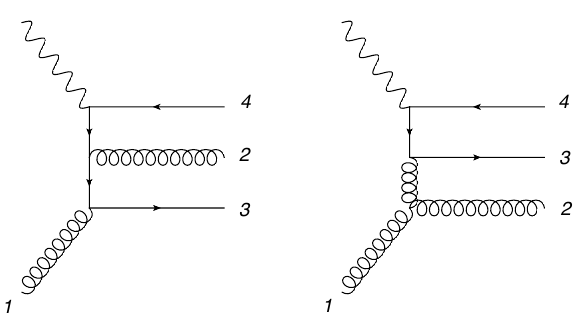
(3 q ; ^1 g ; 2 g ; 4 (cid:22) q ) 2